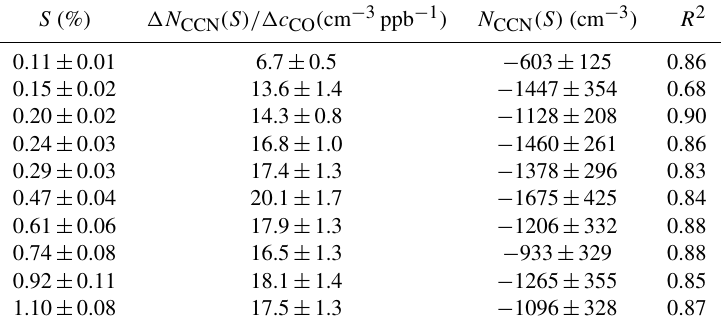
Figure 9. Predicted vs. measured CCN number concentrations calculated from (a) observed ratio N CCN (0.4% )/N CN = 0.36 in An- dreae (2009) and (b) observed (biomass-burning-related) excess CCN to excess CO ratios in M. L. Pöhlker et al. (2017a). The color code shows the number of data points falling into the pixel area, following Jurányi et al. (2011). The black line represents a bivariate regression fit of the data. Table 4. Excess N CCN ( S ) to excess c CO ratios (cid:49)N CCN ( S)/(cid:49)c CO for the individual S levels during peak period of the strong biomass burning event in August 2014. This event is analyzed in detail through a case study in the companion Part 2 paper (M. L. Pöhlker et al., 2017a). The values (cid:49)N CCN ( S)/(cid:49)c CO were obtained from bivariate regression fit of scatterplots between N CCN ( S ) and c CO for individual S levels (Andreae et al., 2012). The parameter N CCN (S) in this table represents the y axis intercept of the linear regression of N CCN vs. c CO at c CO = 0ppb and is, therefore, negative (see M. L. Pöhlker et al., 2017a). S (%) (cid:49)N CCN ( S)/(cid:49)c CO (cm − 3 ppb − 1